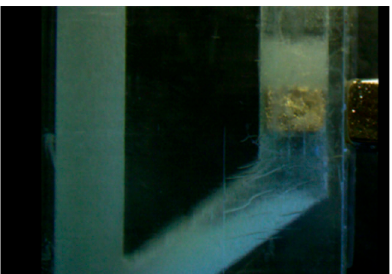
Figure 5. Picture of 3D printed micro-circulating fluidised bed with a magnet inside the system used to measure the solid circulation rate, where 35 µm glass particles at 140 µL/min liquid flow rate was left to accumulate above the magnet for 20 s.